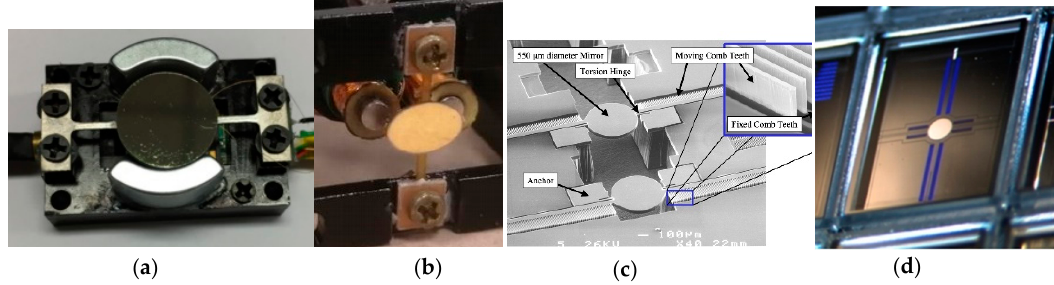
Figure 6. High FoM 1D resonant MEMS mirrors. ( a ) An electromagnetic MEMS mirror made with Ti-alloy structure material [56]; ( b ) An electromagnetic MEMS mirrors made with Flexible Printed Circuit Board (FPCB) structure material [62]; ( c ) An electrostatic MEMS mirror [64]; ( d ) An electrostatic MEMS mirror [60].